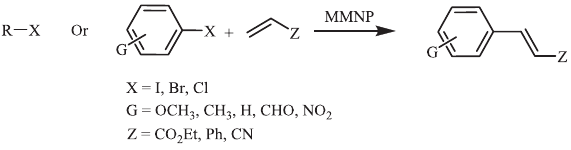
Figure 1: FT-IR spectra of: (a) MNPs@MCM-41, (b)